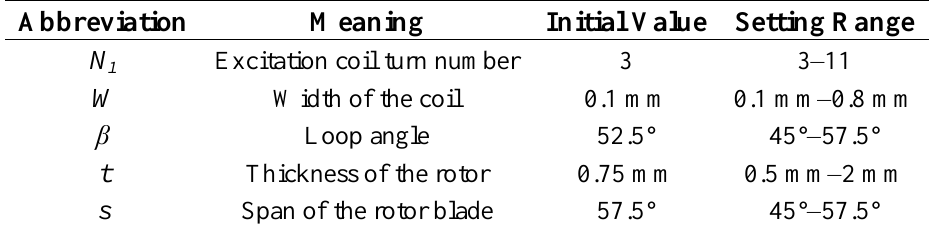
Table 2. Input parameters of sensor